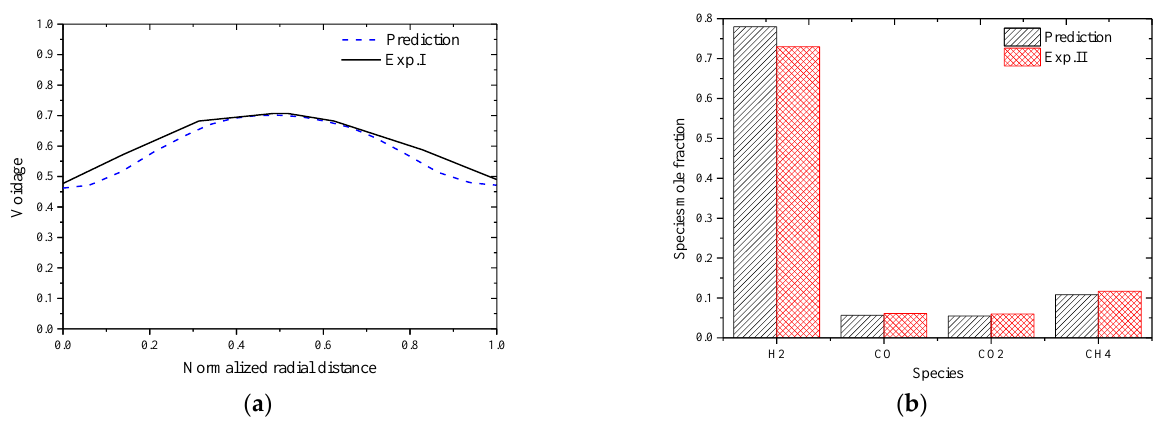
Figure 2. Comparison between predictions and experimental data. ( a ) Voidage comparison between prediction and Exp. I; ( b ) Species molar fraction comparison between prediction and Exp. II. Table 5. Analysis of biomass.